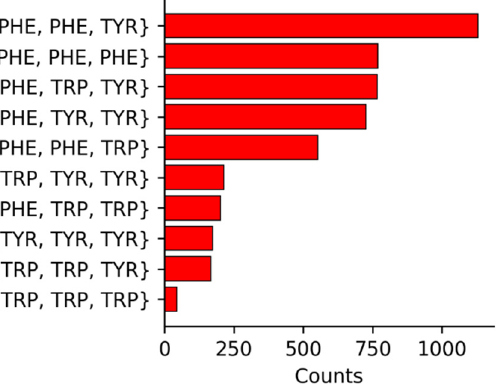
Figure 2. Summary of the identities and incidences of 3-bridge clusters.